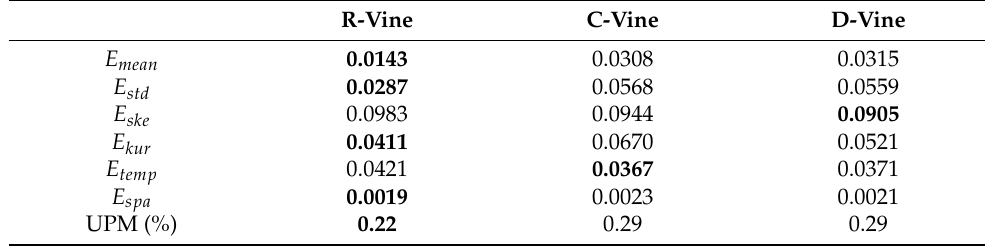
Table 3. Each vine structure’s evaluation